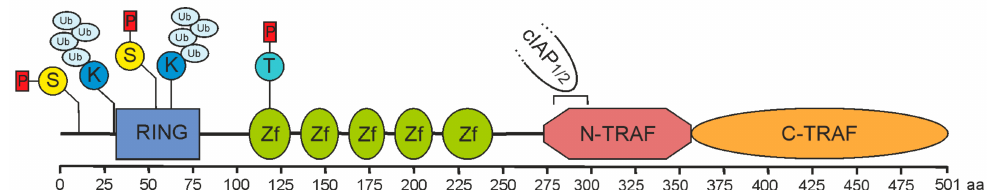
Figure 1. Domain architecture of TRAF2. A sequence of 501 amino acids prescribes the molecular structure of full-length TRAF2. It is essentially composed of a RING domain (aa 32–79), five zinc fingers (Zf) and a TRAF domain comprising a coiled-coil N-TRAF domain with a cIAP1/2 binding site (aa 283–294) [3,4] and a C-TRAF domain. Phosphorylation and ubiquitination sites of known relevance for TRAF2 function are indicated and comprise serine S11 and S55 [5–7], lysine K31 and K63 [8,9], and threonine T117